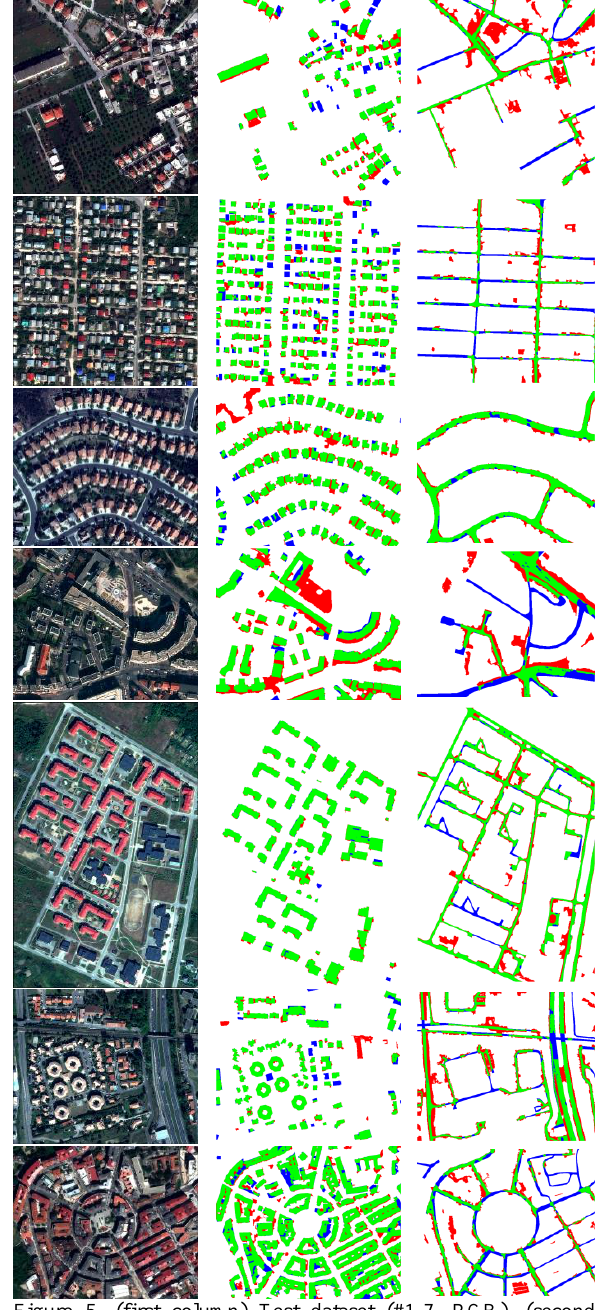
This contribution has been peer-reviewed. The double-blind peer-review was conducted on the basis of the full paper.